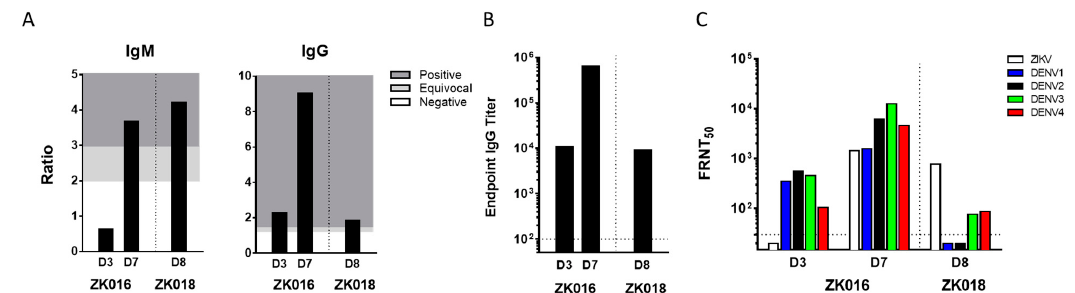
Figure 1. ZIKV neutralizing antibody titers detectable within days after ZIKV infection. ( A ) ZIKV- specific plasma IgM and IgG titers for patient ZK016 at 3 and 7 DPO and for ZK018 at 8 DPO.